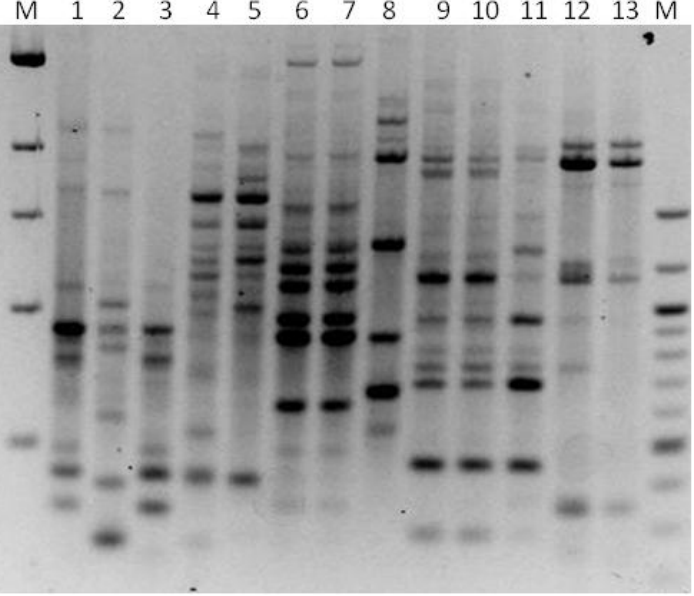
Figure 7. RAPD profiles generated with primers (GTG)3. M: 1 kb DNA marker; 1: P. anomala Pa P9;